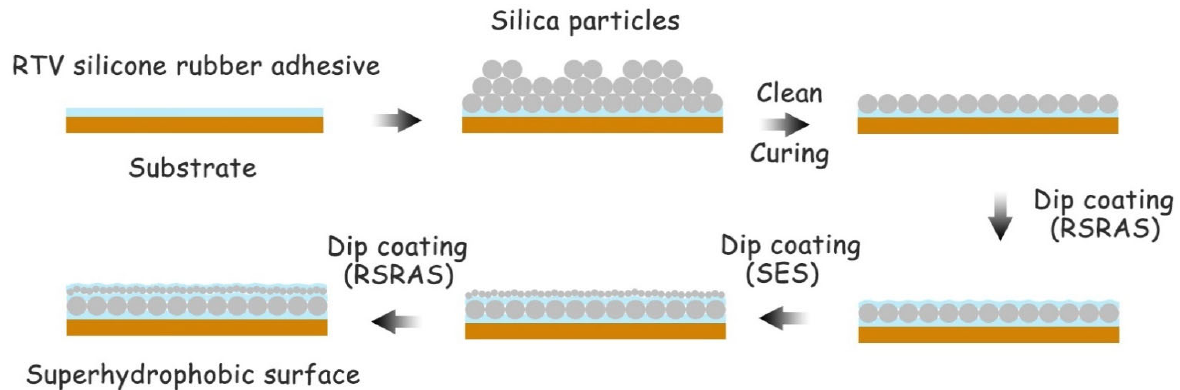
Table 1. Composition of different